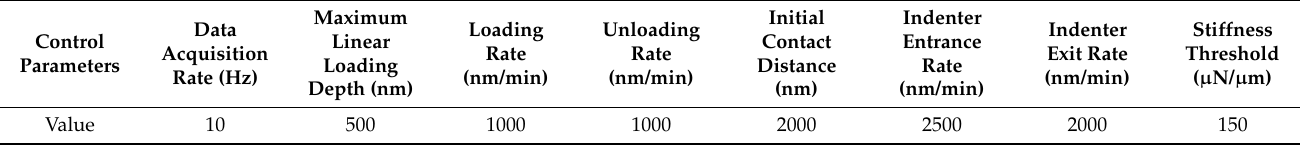
Table 2. Control parameters of nanoindentation